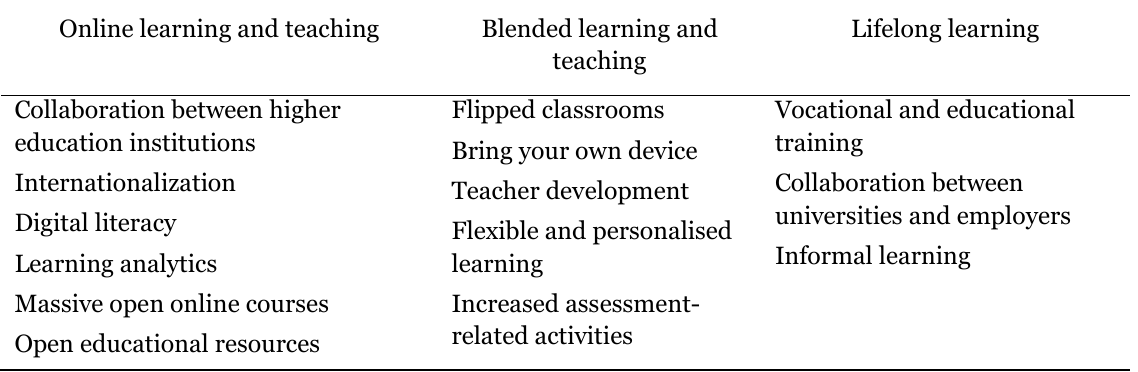
Trends Identified in Desk Research